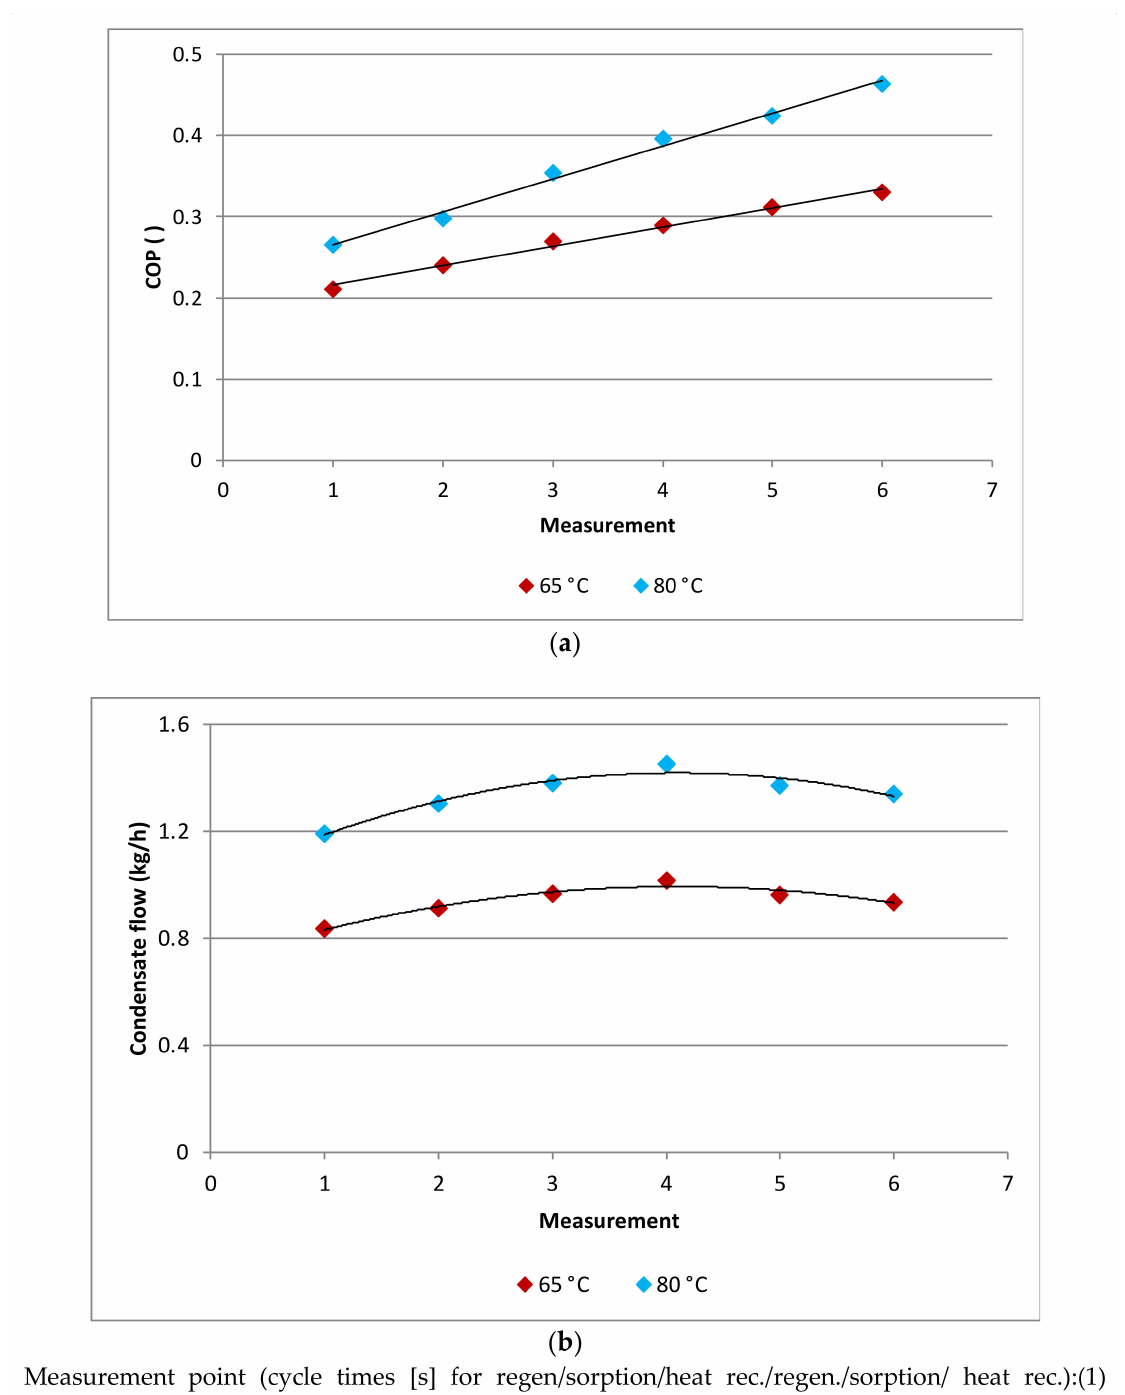
Figure 9. Experimental testing results in GROUP 1 at the hot water temperatures of 80 ◦ C and 65 ◦ C: ( a ) COP; ( b ) condensate